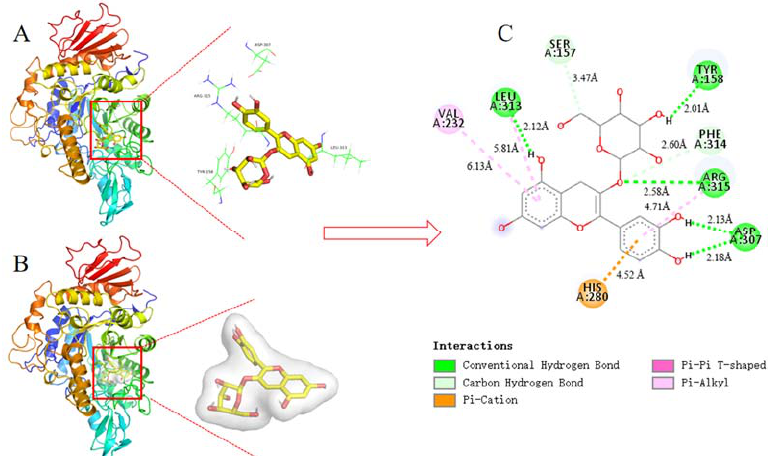
Figure 8. The 3D structure of α‐ glucosidase including active amino acid and docking active site ( A ); 3D docking mode between C3G and α‐ glucosidase simulated by Discovery Studio and the amino acid of active site ( B ); 2D schematic inter ‐ action diagram between C3G and α‐ glucosidase, the color of amino acid residue is drawn by interaction ( C ). The hydrogen bonds interaction between C3G and the amino acid residue of α‐ glucosidase is shown in green, and the hydrophobic interactions between C3G and the amino acid residue of α‐ glucosidase are described in purple, light purple, and